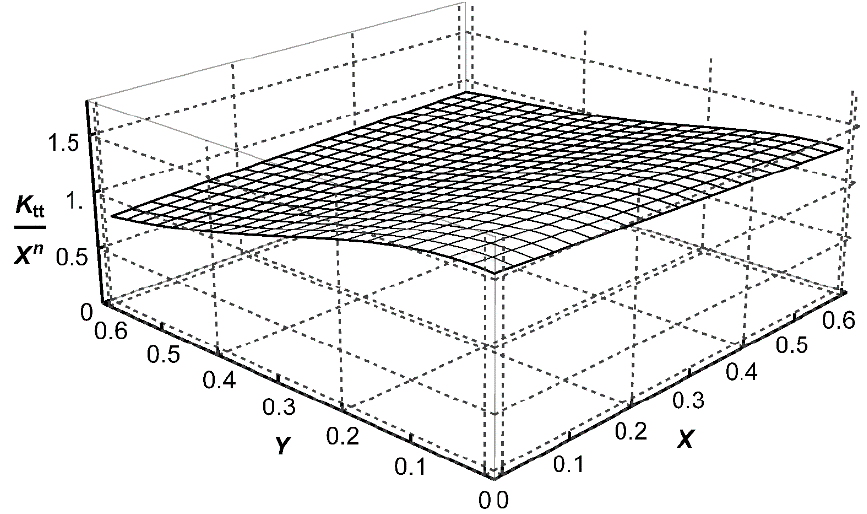
n P K X = for θ = 45°, n = − 0.3264 and Z 0 = 1. n t tt P K X = for θ = 45°, n = − 0.3264 and Z 0 = 1. t tt